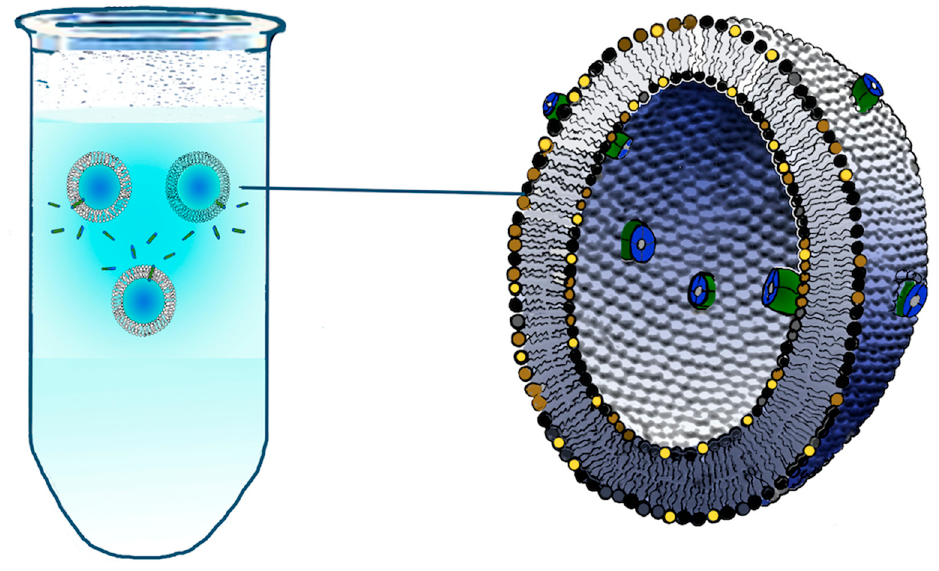
Figure 2. Schematic representation of liposomes containing channels/transporters. Liposomes are synthetic lipid vesicles where a lipid milieu separates the internal aqueous medium from the external ionic environment. After the dispersion of lipids in water solutions liposomes of different sizes (from 20–30 nm to several microns) and lamellarity can be obtained by changing the preparation method. Large and small unilamellar vesicles can be obtained from multilamellar vesicles by different methods such as ultrasonic treatment, or several extrusion cycles either through a small orifice under high pressure or through a polycarbonate membrane [59] (for a complete review, see Ref. [60]). Protein enriched liposomes (proteoliposomes) containing ion channels/transporters can be reconstructed from an incredible number of lipids that incorporate purified transport proteins from a variety of plasma or organellar membranes [60]. In turn, the reconstitution of cell/organellar planar membranes is achieved by the fusion of proteoliposomes to preformed PLM or BLM. Furthermore, native vesicles can be obtained by standard methods of cell fractionation, homogenization and centrifugation of native plasma as well as organellar membranes, including lysosomes [55,61]. Liposome and vesicle fusion with artificial bilayers can be facilitated by different procedures and tricks such as the presence of organic n-alkane solvents in the bilayer, the stirring of the bath solutions, the addition to the bath of millimolar concentrations of divalent cations, the existence of an osmotic pressure between the solutions present in the two compartments, the presence of nystatin and ergosterol in the proteoliposomes or even by centrifugal forces.